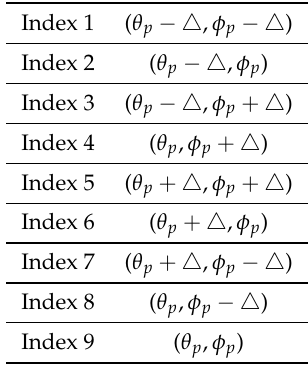
Figure 3. Indexes of the nine possible positions of an electrode. Table 1. Relationship between the index and the